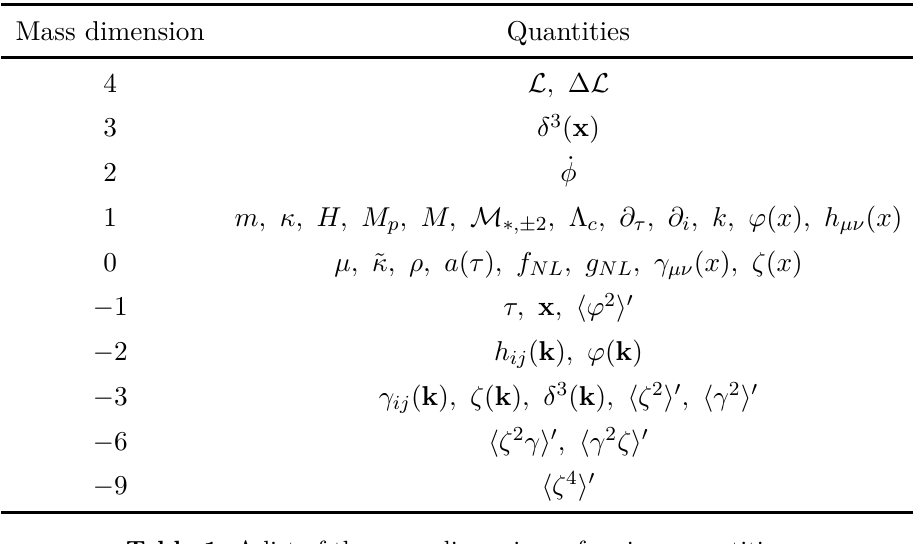
Table 1 . A list of the mass dimensions of various